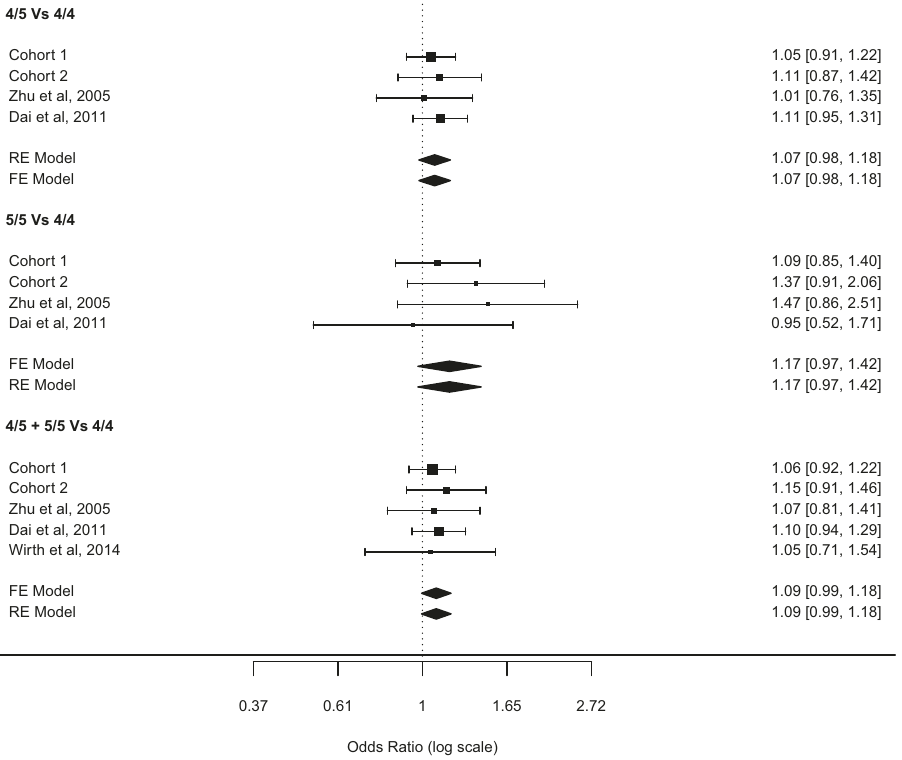
Fig. 1 Meta-analysis results. Displaying pooled estimates obtained by combining information about C1 and C2 cohorts and Zhu, Dai and Wirth studies under the three different models (homozygous, heterogeneous, and